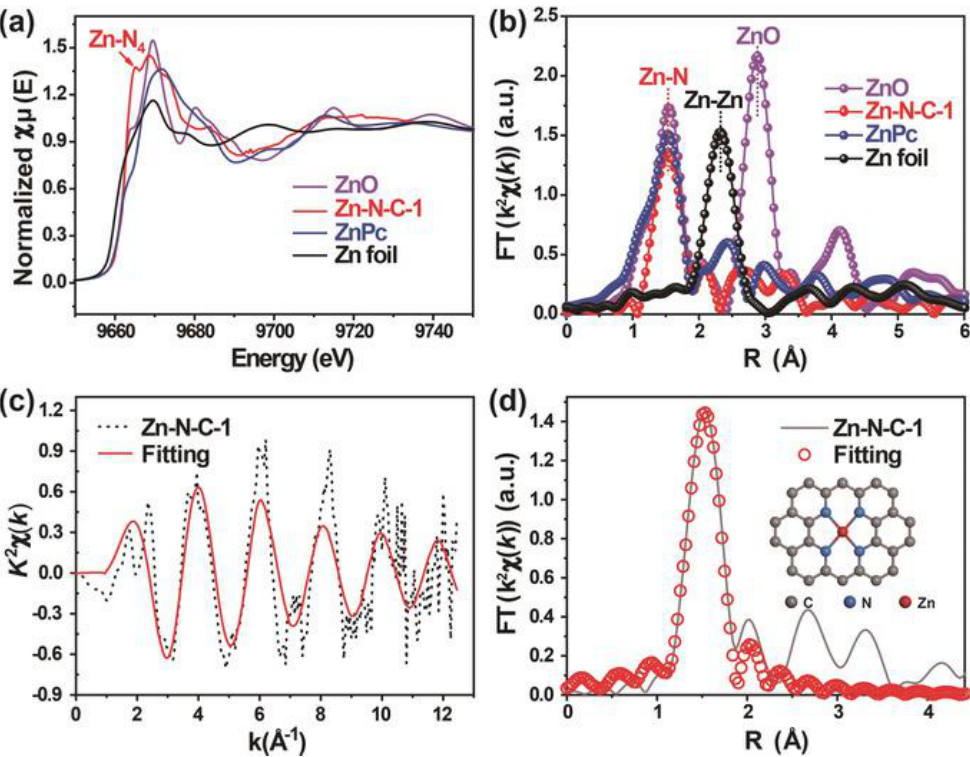
Figure 8. ( a ) XANES spectra of the Zn K-edges of Zn-N-C-1, ZnO, ZnPc, and Zn foil. ( b ) Fourier transforms (FTs) of the k 2 -weighted χ (k) functions of Zn K-edge EXAFS spectra. ( c , d ) Corresponding EXAFS spectra fit in k- and R-space, respectively; insets show the model of the Zn coordination environment. (Reprinted with permission from [86]. Copyright 2019, John Wiley and Sons).